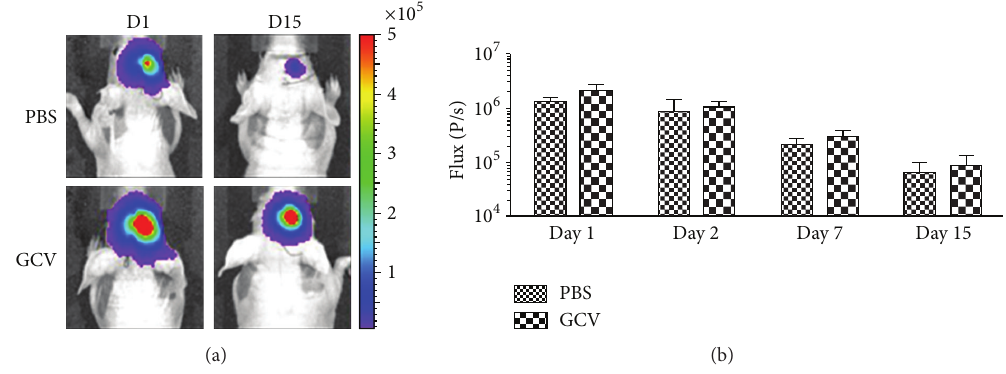
Figure 5: In vivo validation of BLI signal intensity and hMultistem survival in Hsd:Athymic- FoxN1 nu mice. (a) Bioluminescence images of a representative animal that received 5 × 10 5 hMultistems (day 1) and was treated from day 2 to day 15 with either PBS or GCV (50 mg/kg). (b) Quantification of BLI signal intensities shows that (1) the stem cells were detectable by BLI, (2) stem cell survival was reduced in the environment of the host’s brain, and (3) no statistically significant difference in stem cell viability between the PBS and GCV receiving animals was detected. Number of animals was 6 per